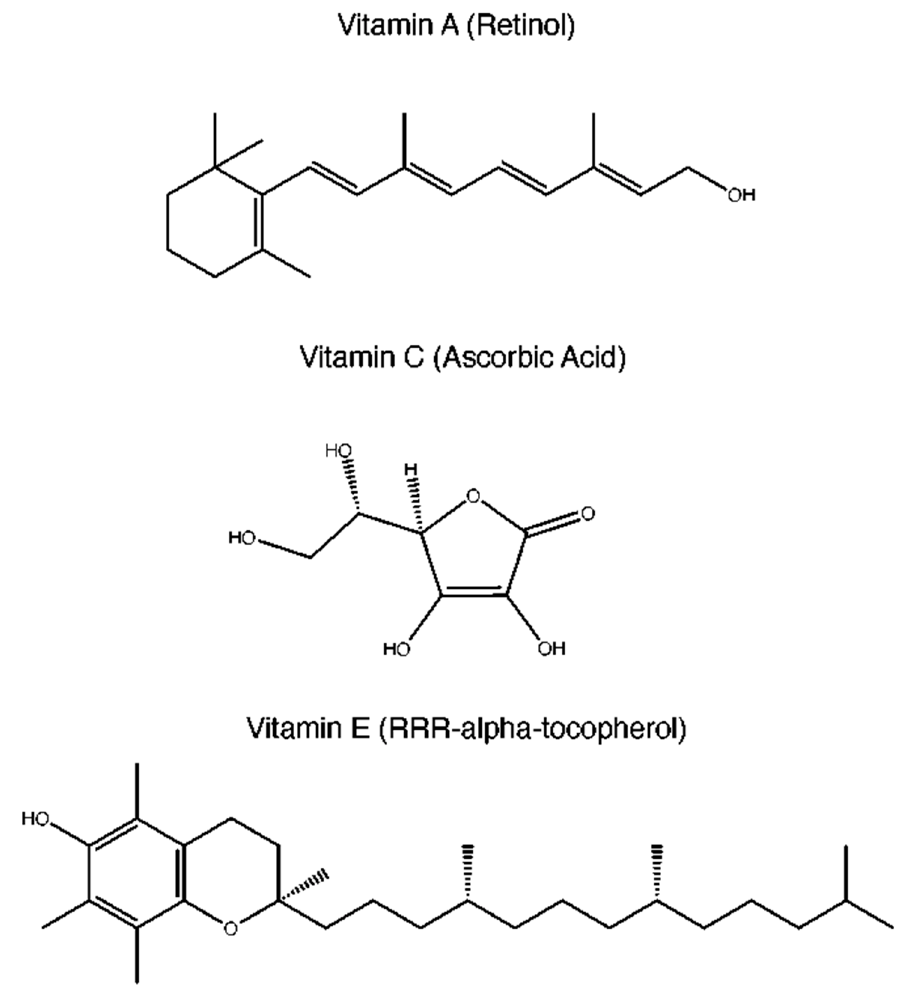
Figure 1. Chemical structures of vitamins A, C, and E.